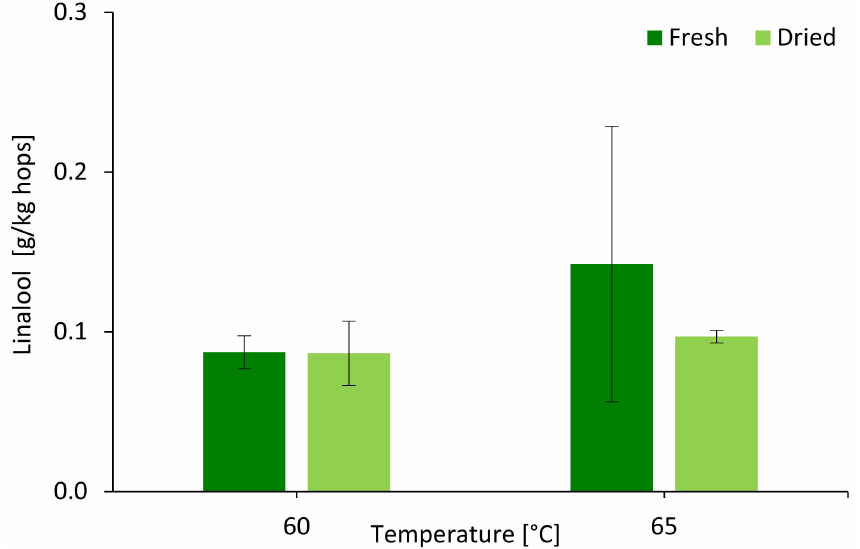
Figure 10. Results obtained from gas chromatography analysis for linalool in g / kg hops at 0 min and 210 min for hop cones dried at 60 ◦ C and 65 ◦ C at 0.35 m / s.